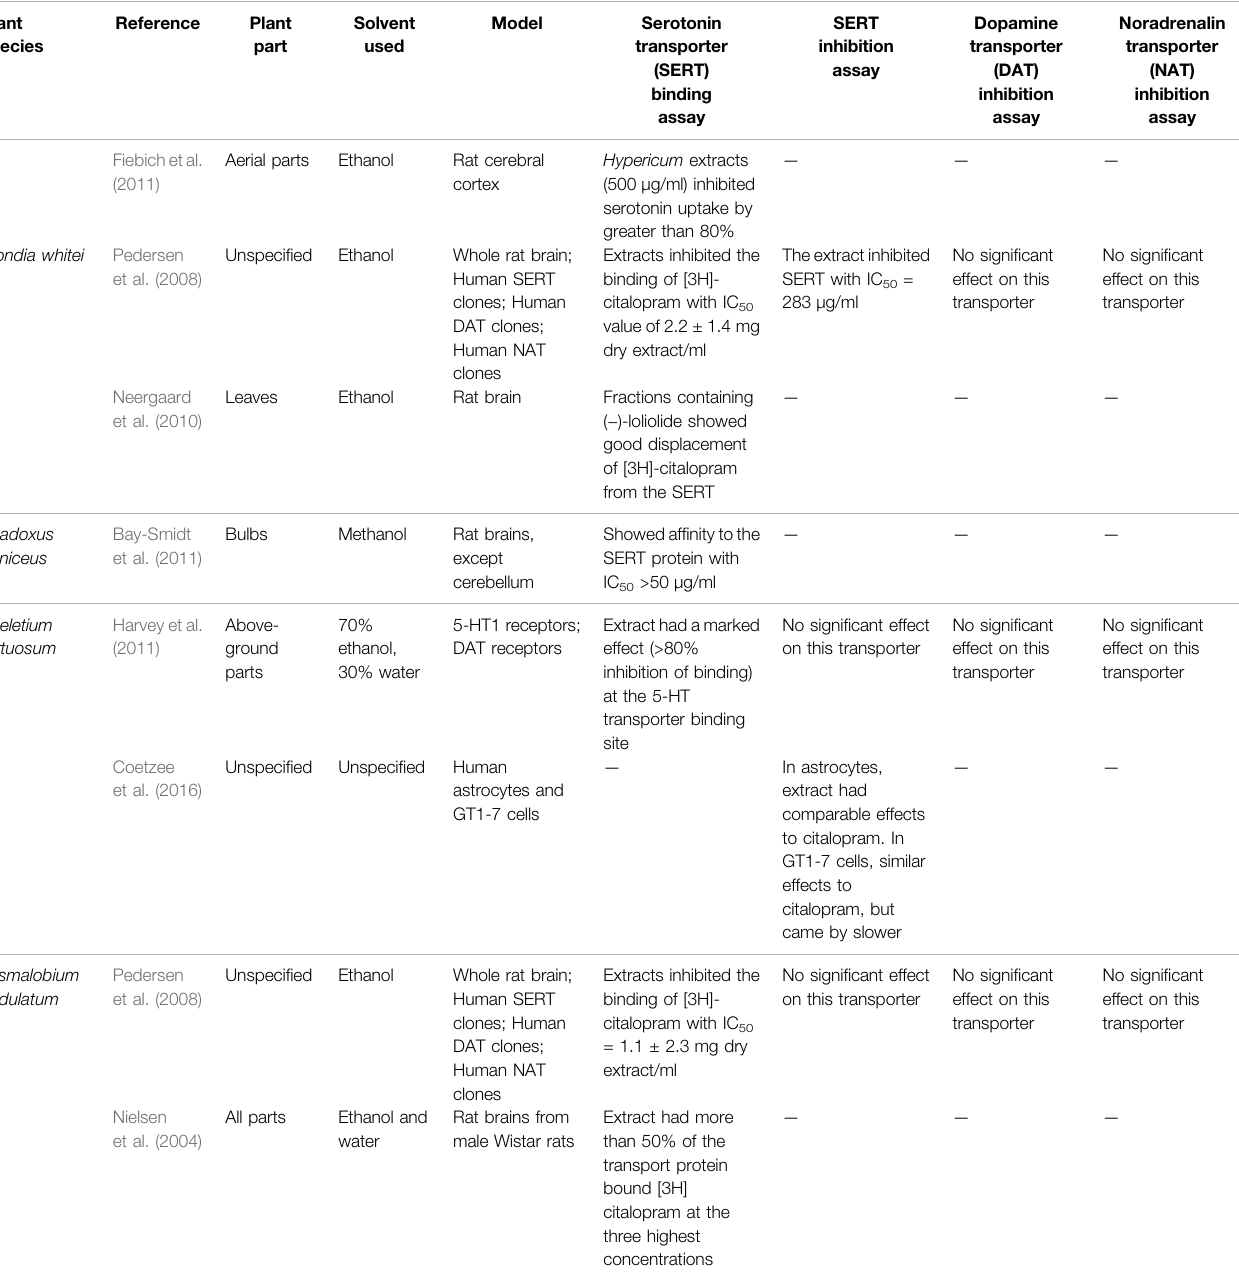
TABLE 4 | ( Continued ) Different in vitro assays utilized for investigating the antidepressant potential of medicinal